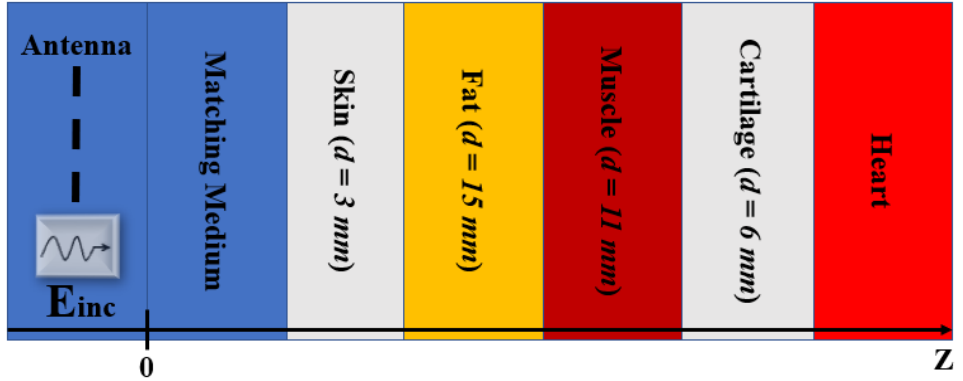
Figure 2. The 1-D planar layered model of the human thorax. The model is composed of five layers including skin, fat, muscle, cartilage, and heart. E inc is the probing wave. The different colours of the layers are chosen to distinguish between the considered tissues.